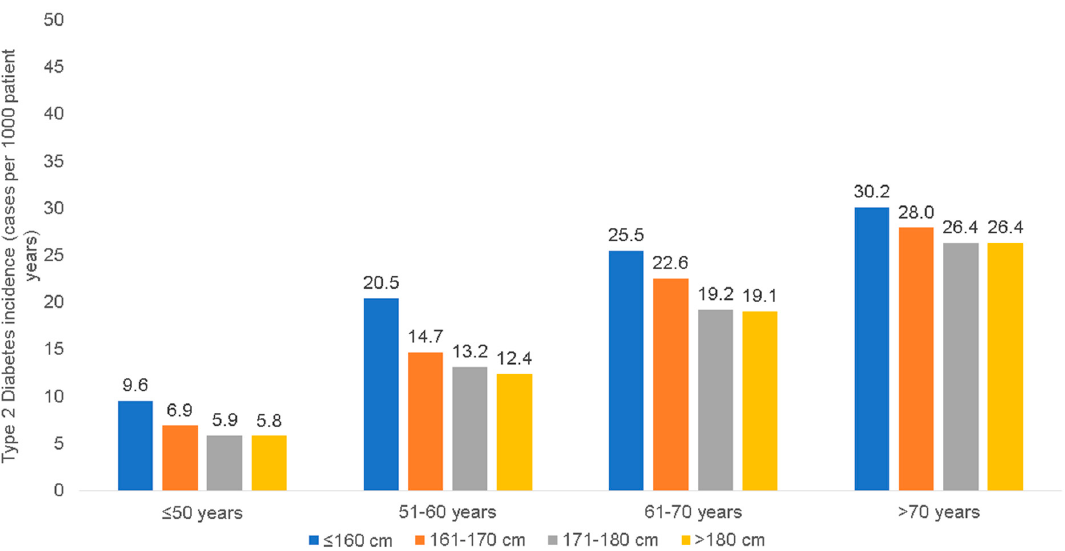
Figure 1. Incidence of type 2 diabetes by age and body height among women.